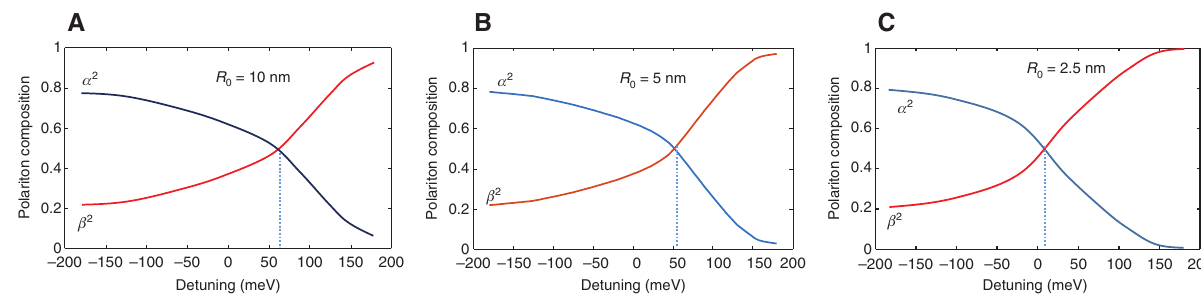
Figure 5: Polariton composition ( α 2 is plasmonic and β 2 is excitonic weight) versus the energy of the “undressed” surface plasmon relative to the bandgap energy for three different radii of the Ag nanosphere.